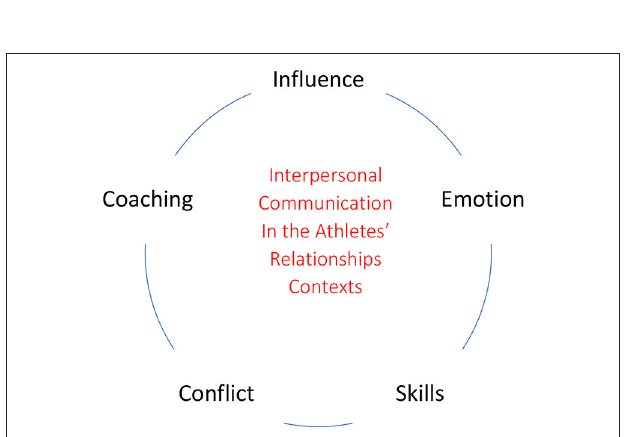
FIGURE 2 | Main keywords for interaction analysis through systematic